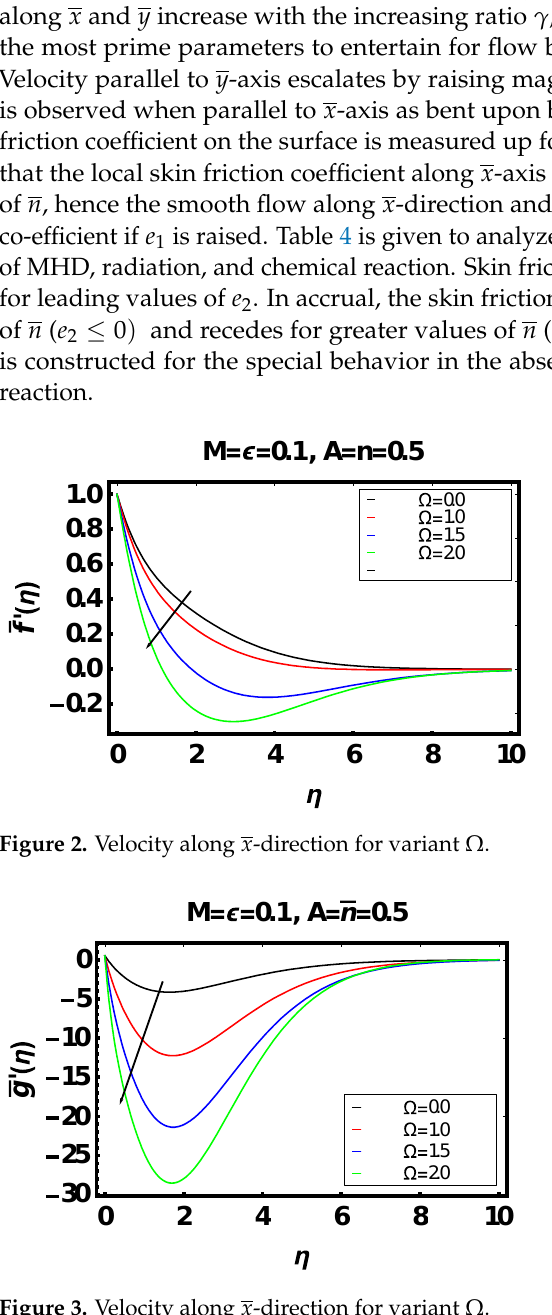
Figure 4. Velocity along 𝑥̅ -direction for variant 𝑛̅. Figure 5. Velocity along 𝑦̅ -direction for variant 𝑛̅.